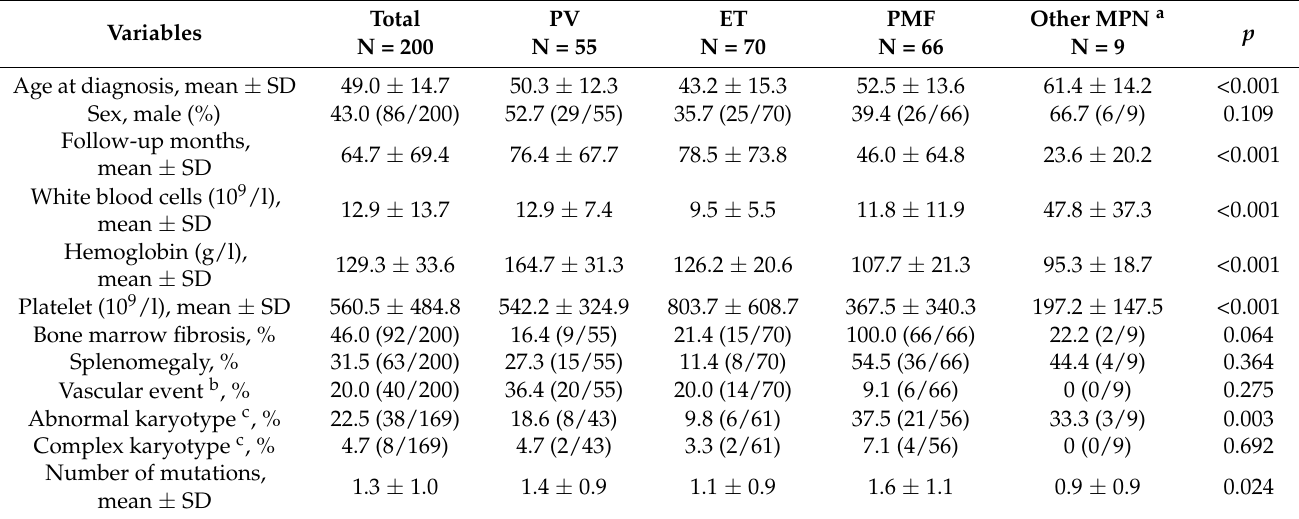
Table 1. Overall characteristics of patients in this